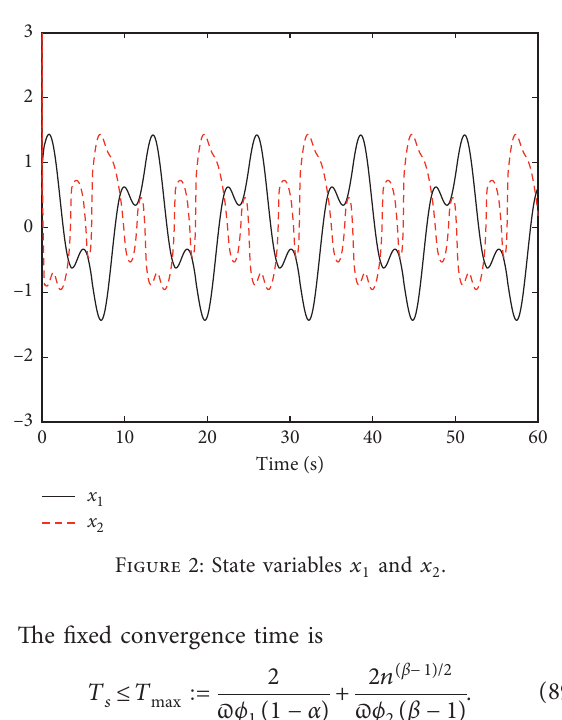
Figure 1: System output y and reference signal y